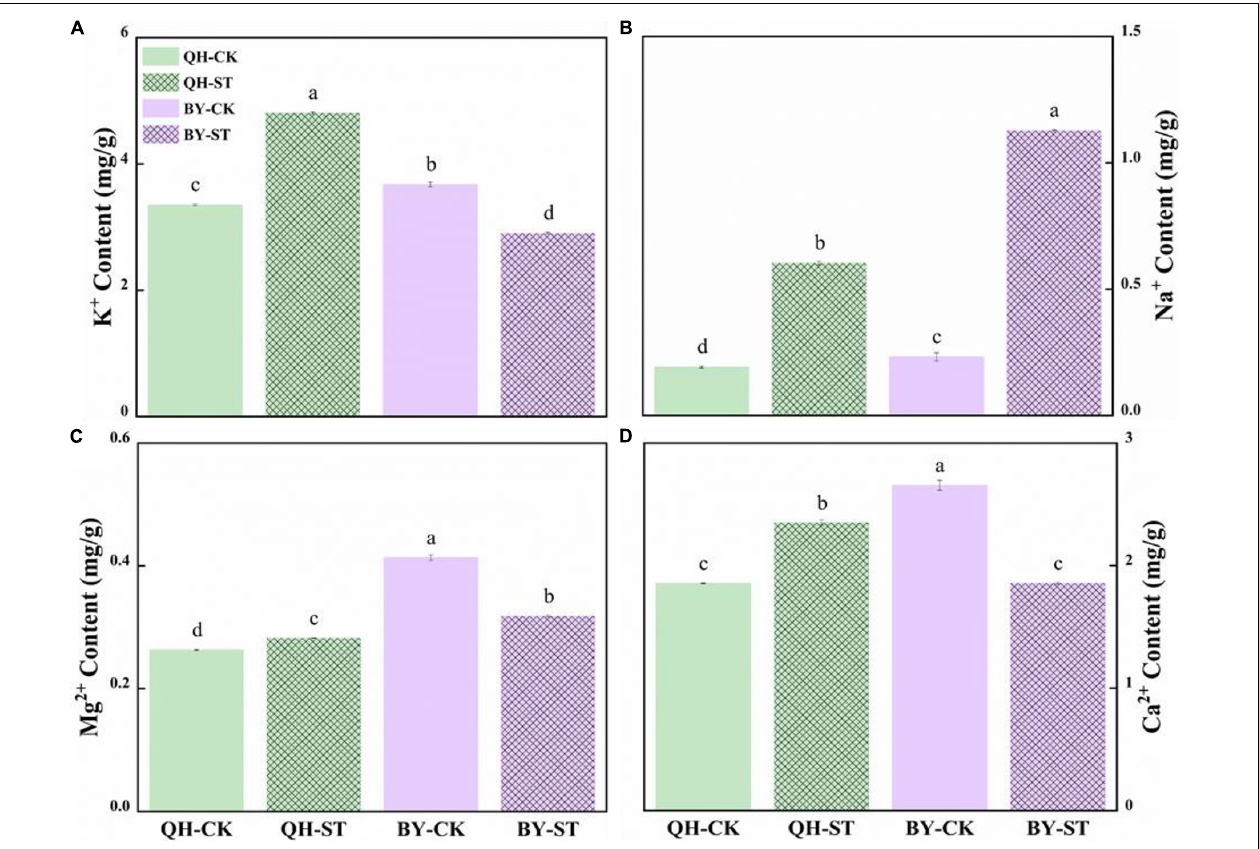
FIGURE 4 | Effect of salt on the content of ions in the leaves of Qinghua45 (QH) and Biyuchunhua (BY). (A) Content of K + . (B) Content of Na + . (C) Content of Mg 2 + . (D) Content of Ca 2 + . All data were determined 20 days after NaCl treatment. Data are the means ± SD, and the different letters (a–d) indicate a significant difference at P < 0.05 according to Duncan’s